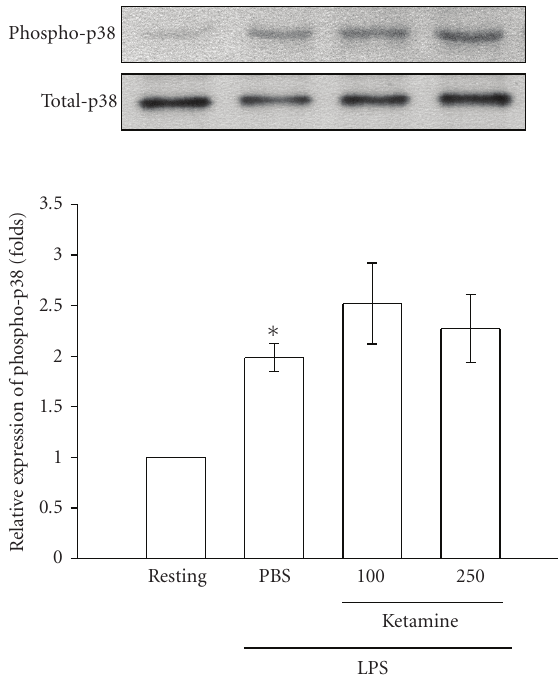
Figure 7: E ff ect of ketamine on p38 MAPK phosphorylation in lipopolysaccharide (LPS)-activated microglia. Microglia (5 × 10 5 cells mL − 1 ) were treated with ketamine (100 and 250 μ M) or an isovolumetric PBS bu ff er for 30 minutes, followed by the addition of LPS (100ng mL − 1 ) for 45 minutes. p38 MAPK phosphorylation was determined by Western blotting with a monoclonal antibody which recognizes only phosphorylated p38 MAPK. Data are presented as the means ± S.E.M. ( n = 3). ∗ P < . 05, compared to the resting